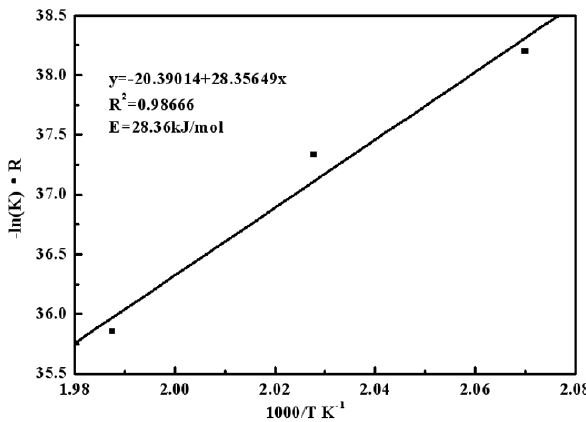
Figure 11. Plots of − ln(k) * R versus 1000 / T to determine activation